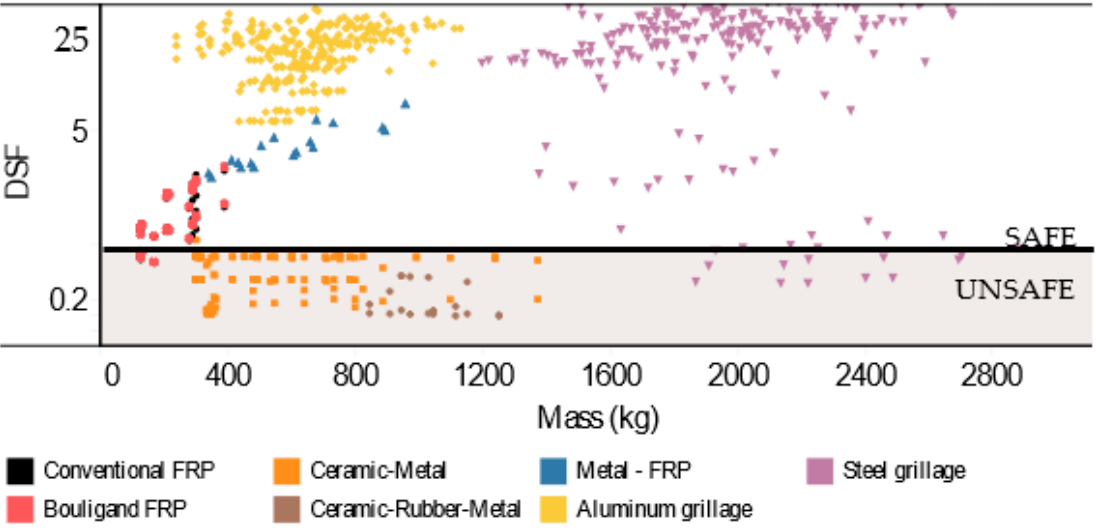
Table 6. Best parametric combinations by material in terms of SSF, SpW and mass.